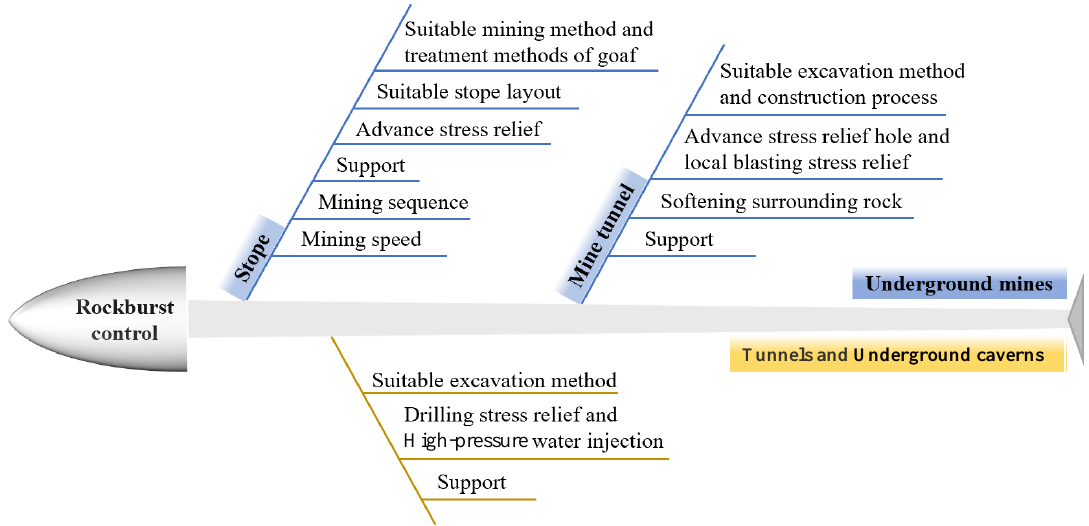
Figure 10. Control measures of rockburst.